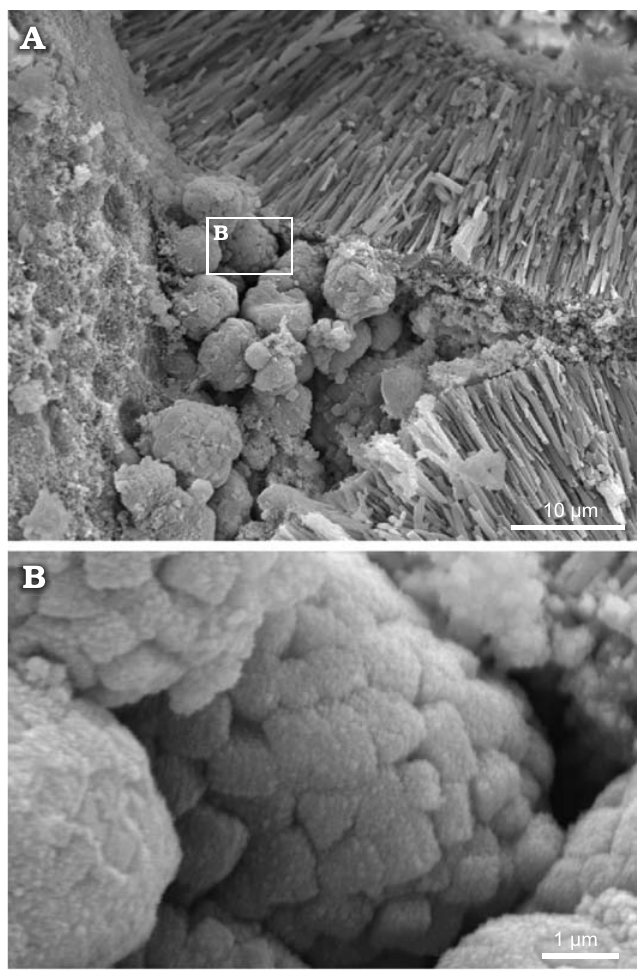
Fig. 8. Polyphysacean alga Acetabularia moldavica sp. nov., MP-UAIC 8228/PD.1a, early Sarmatian, P ă tr ă u ț i (Suceava County, Romania). A . Space among three mineralized gametangia (cysts), partially filled by calcareous micro-spherules. B . Detail of micro-spherules, showing the equant crystals.